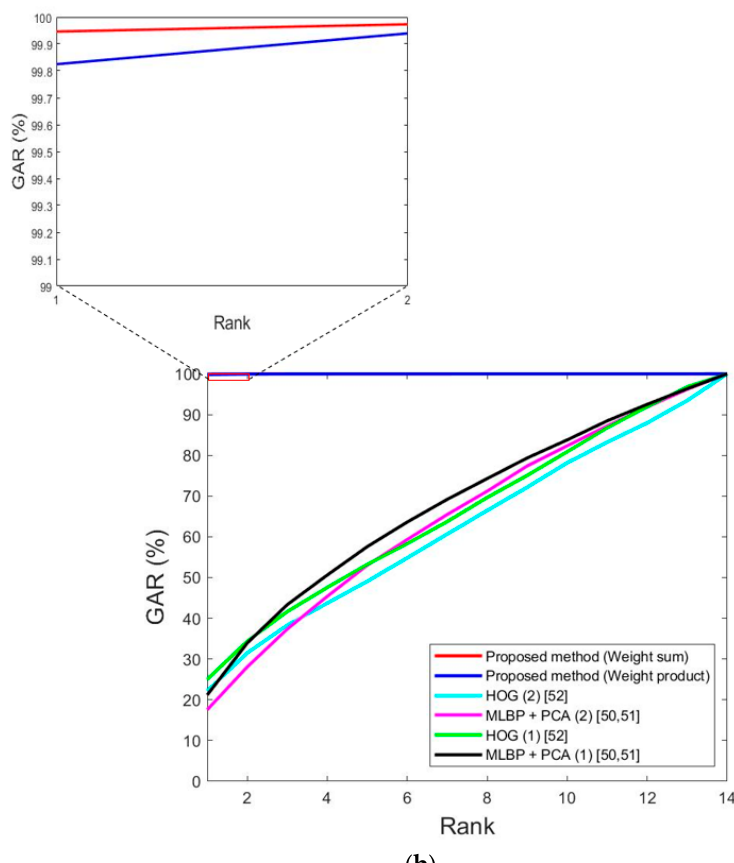
Figure 17. CMC curves by proposed and previous methods. With ( a ) Dongguk face and body database (DFB-DB1) and ( b ) ChokePoint dataset. In ( a , b ), multi-level local binary pattern (MLBP) + principal component analysis (PCA) (1) and MLBP + PCA (2) mean the methods of MLBP + PCA based on geometric center by feature difference and pixel difference of Table 12, respectively. In addition, histogram of oriented gradient (HOG) (1) and HOG (2) mean the methods of HOG based on geometric center by feature difference and pixel difference of Table 12, respectively.